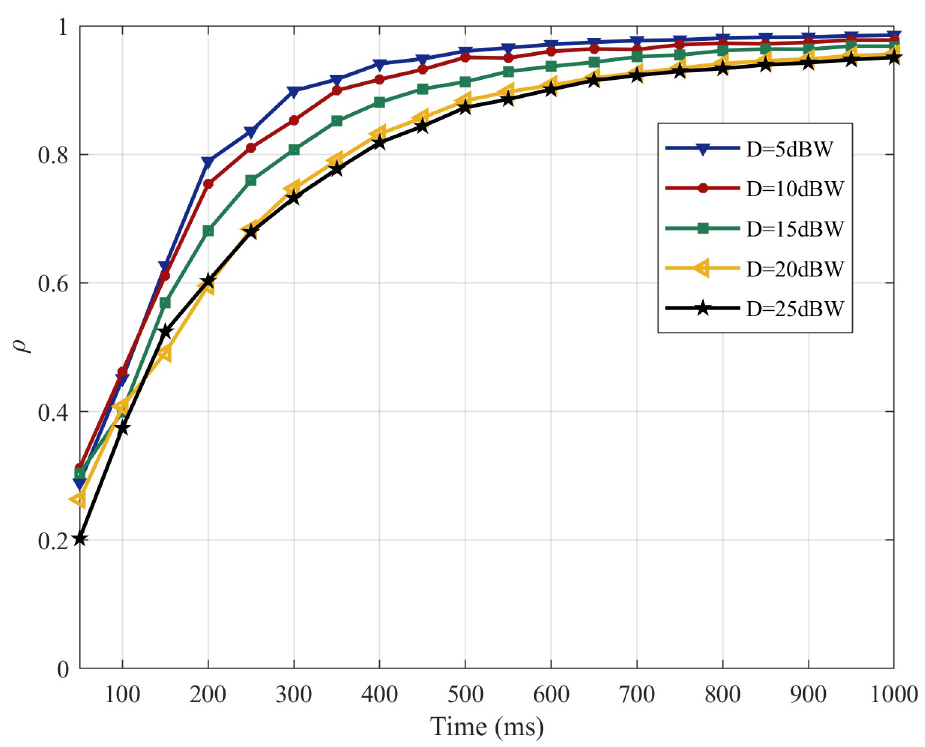
Fig 9. The change in the ρ with different noise